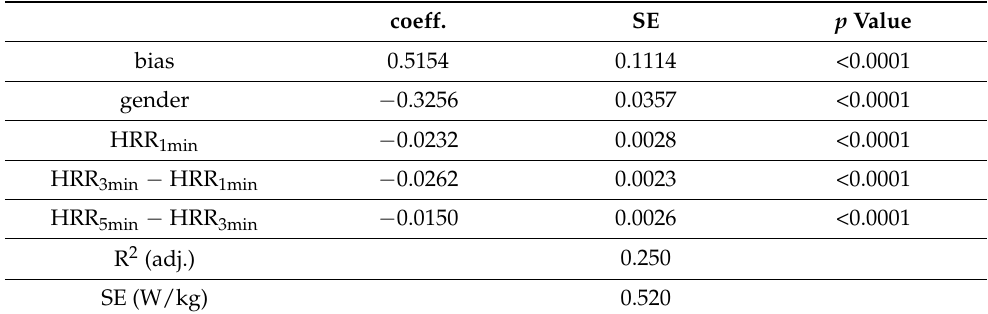
Table 3. Multiple linear regressions of weight-related performance at IAT in W/kg using gender (m = 0, f = 1) and HRR